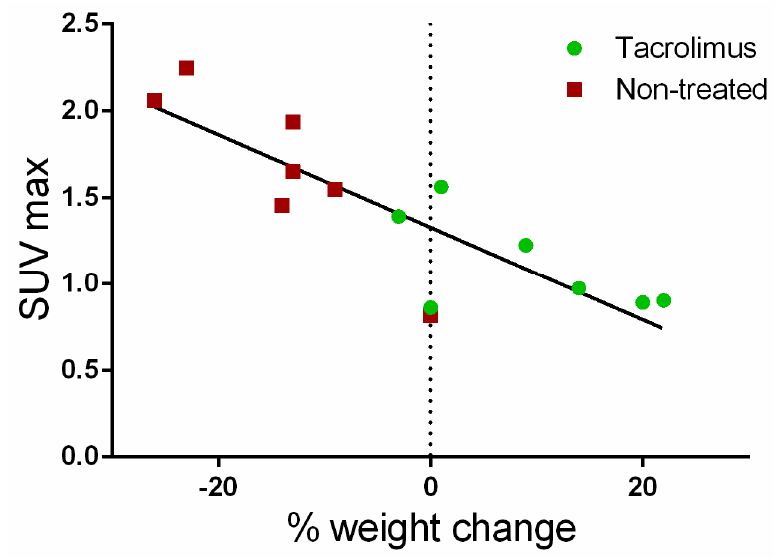
Figure 8. Correlation of average SUV max values with body weight changes from the baseline (dotted line).